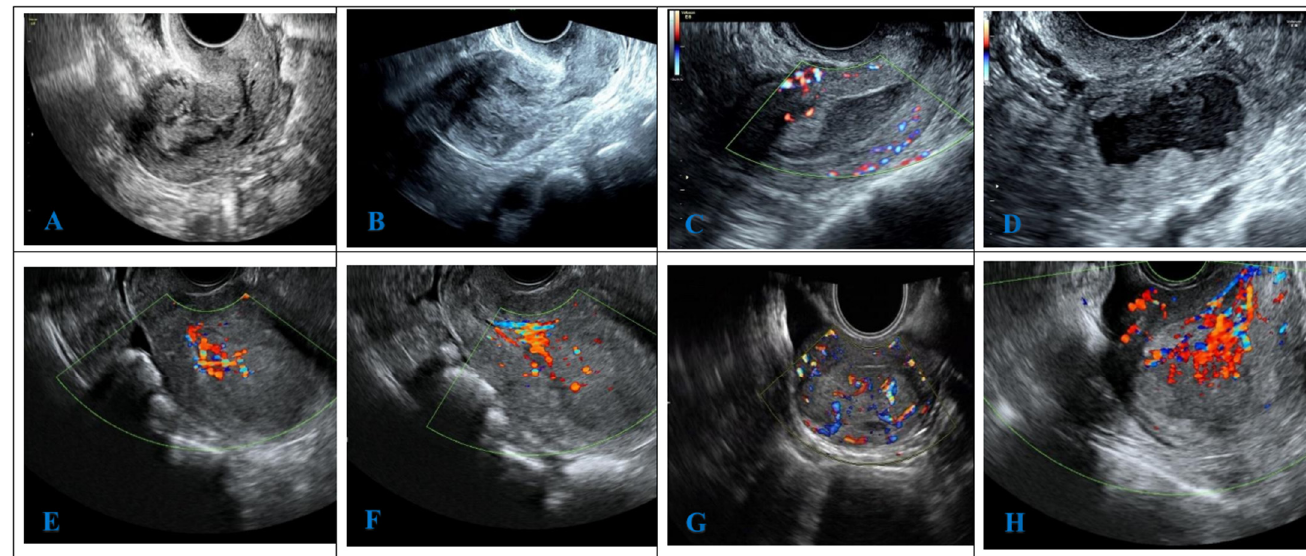
Figure 2. Images of malignant IETA ultrasonographic features. ( A ) Heterogeneous with irregular cysts and endometrial–myometrial junction: “interrupted”; ( B ) Endometrial midline appearance: “not defined” and endometrial–myometrial junction: “not defined”; ( C ) Intracavitary fluid: “ground glass”; ( D ) Intracavitary fluid: “mixed” echogenicity; ( E , F ) Vascular pattern: Multiple vessels (focal origin); ( G ) Vascular pattern: Multiple vessels (multifocal origin); Color score: moderate amount of color/moderate vascularity (3 points); ( H ) Color score: abundant color/abundant vascularity (4 points).